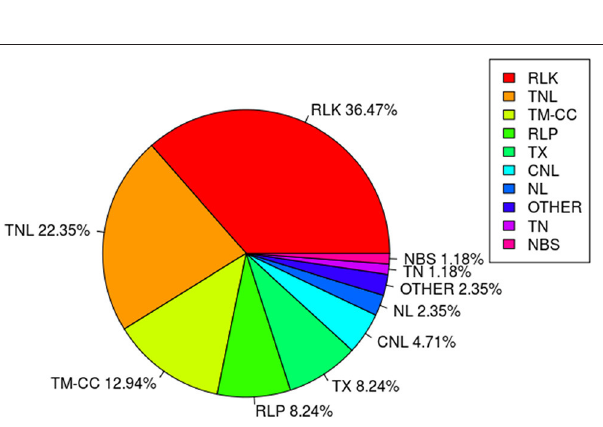
FIGURE 7 | Class distribution of resistance gene analogs (RGAs) located within 200Kb flanking regions of